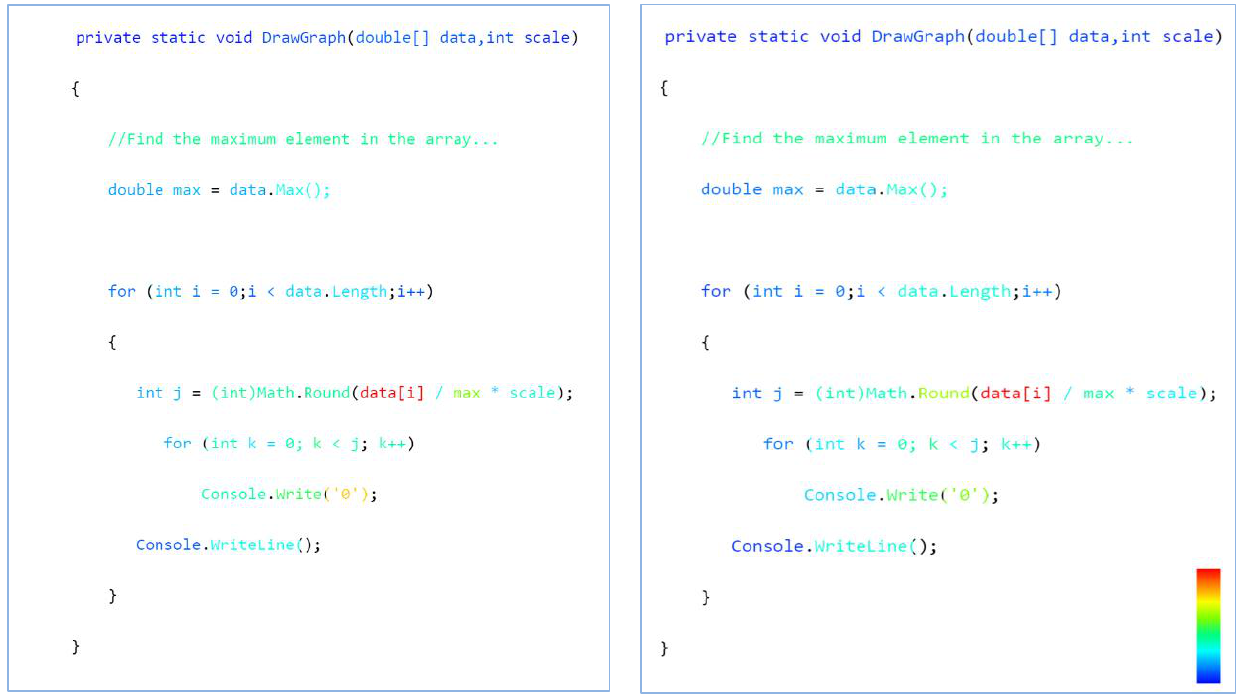
Figure 4. Heatmaps of first snippet for (a) black-and-white code on the left and (b) colour code on the right